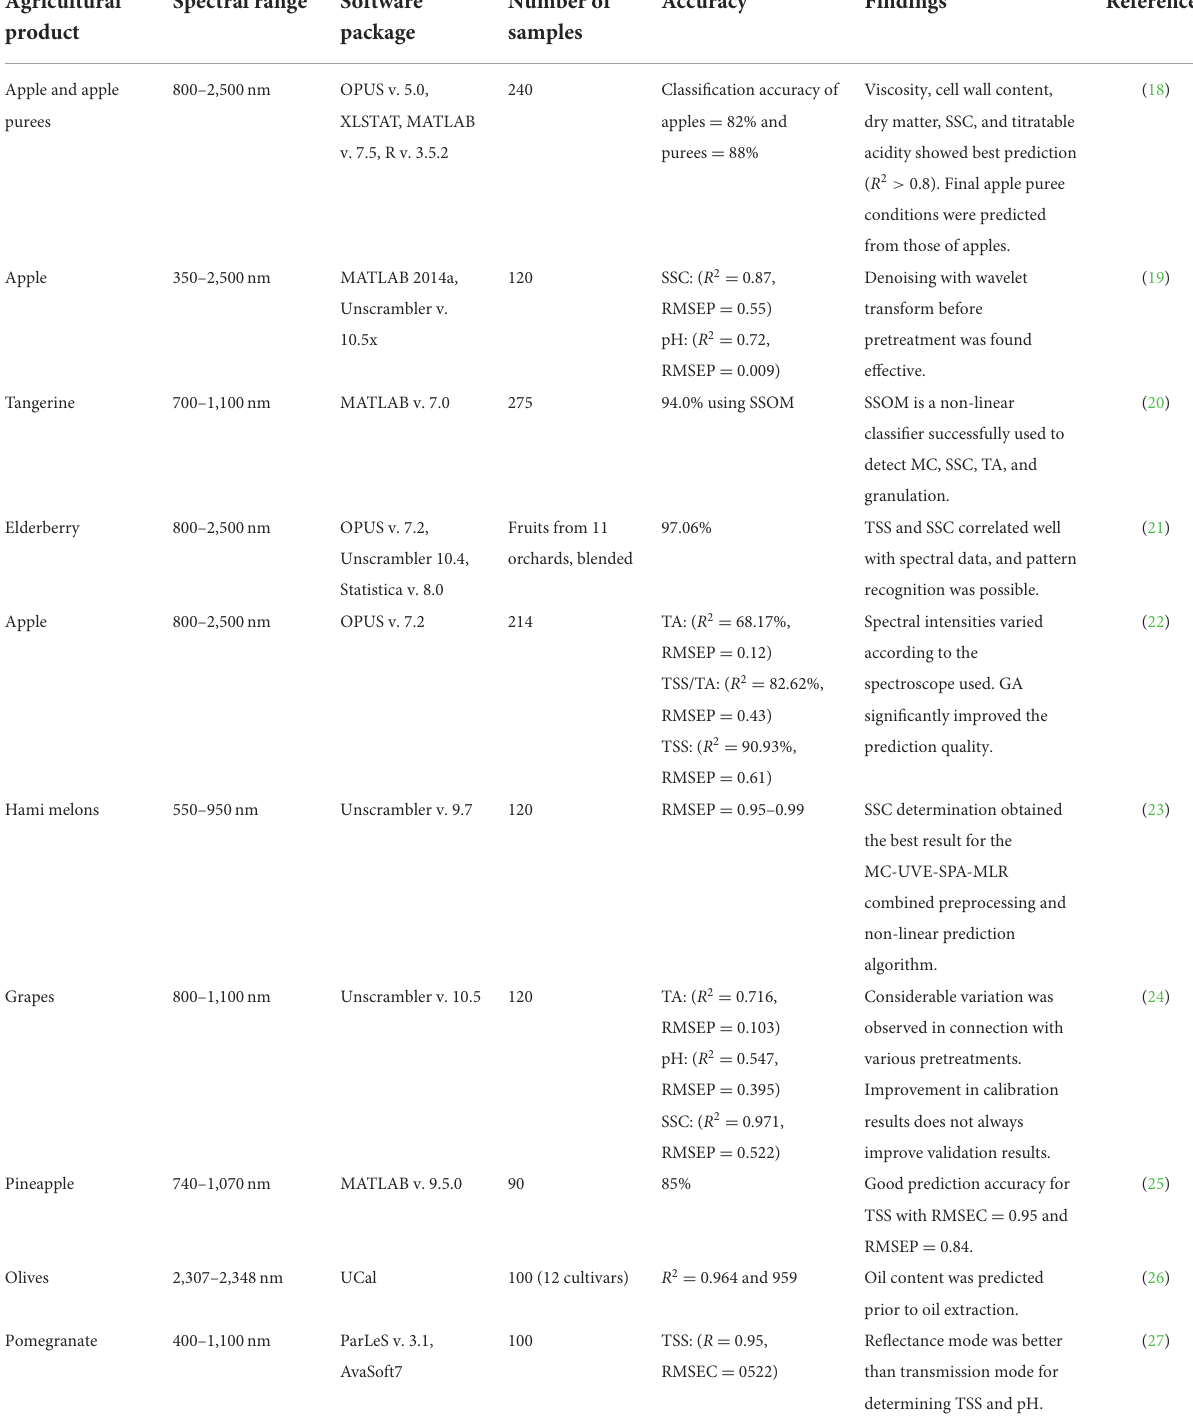
TABLE 1 Uses of NIRS to determine the quality aspects of various agricultural